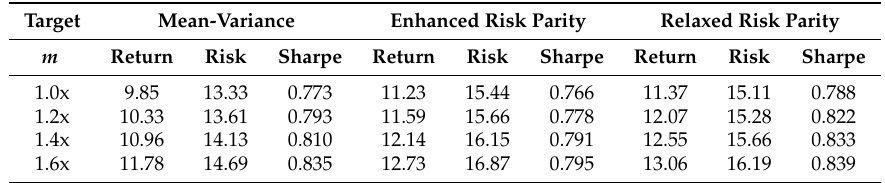
Table 7. Annualized out-of-sample performance.